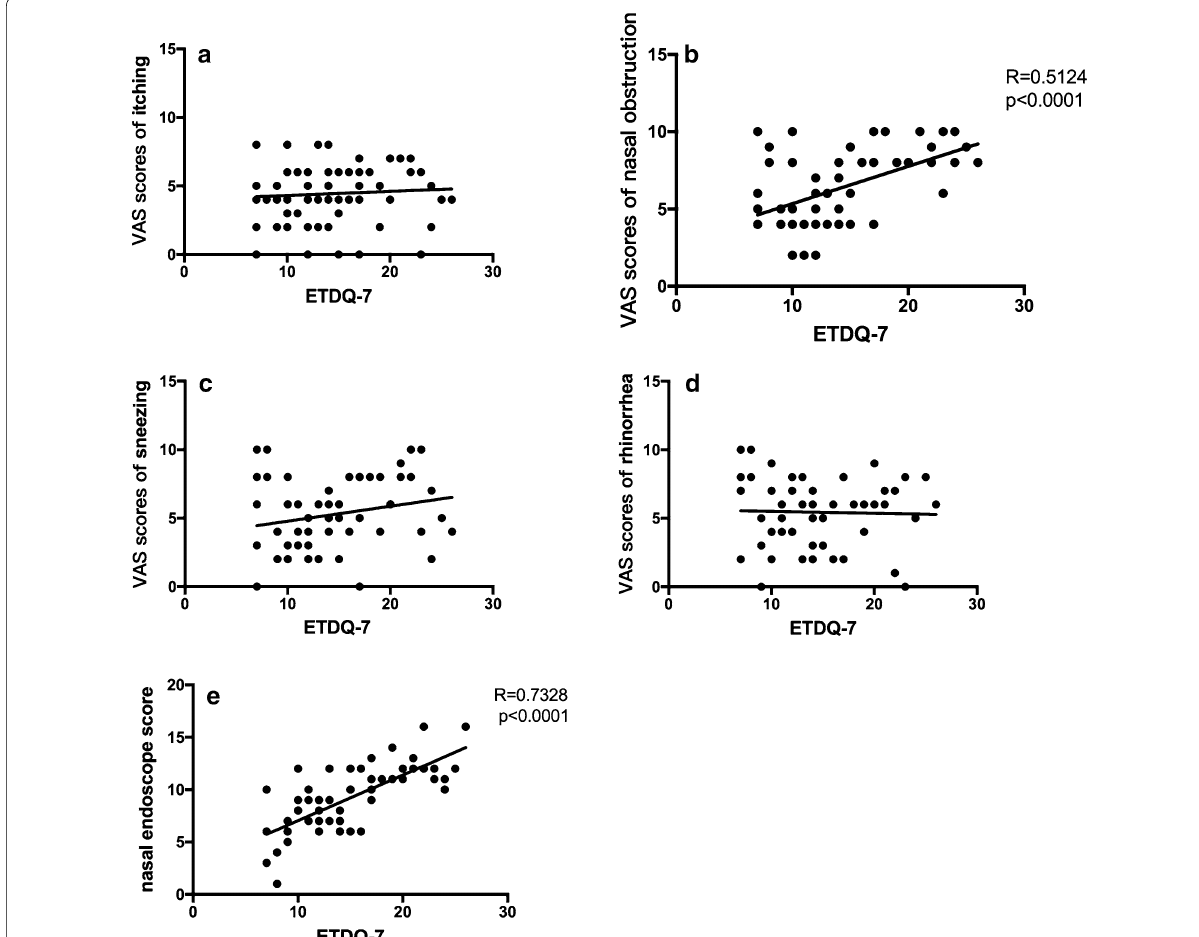
Fig. 2 Correlation of nasal symptoms and endoscopic scores with eustachian tube function in HDM-allergic rhinitis patients. a The Pearson correlation coefficient between ETDQ-7 and itching VAS scores (normal distribution) was r coefficient between ETDQ-7 and nasal obstruction VAS scores (non-normal distribution) was r coefficients between ETDQ-7 and sneezing scores (normal distribution) was r ETDQ-7 and rhinorrhoea scores (normal distribution) was r nasal endoscopic scores (normal distribution) was